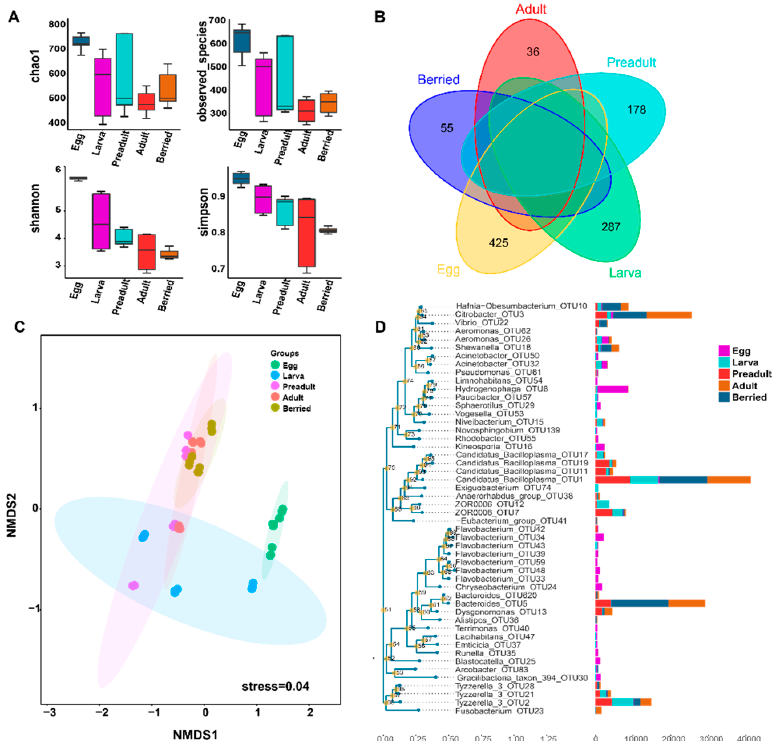
Figure 3. Trajectory of the gut microbiota in crayfishes across developmental stages. ( A ) The α -diverdity indexes (including observed species, Chao1, Shannon and Simpson) of crayfish during developmental stages. ( B ). Venn diagram showing OUT numbers change according to sample types. ( C ) Non-metric Multi-Dimensional Scaling ordination (NMDS) showing that bacterial communities cluster by sample types using the unweighted UniFrac distance. Adonis test, R 2 = 0.382, p = 0.001. ( D ) The phylogenetic tree of top 50 OTUs relative to the relative abundance.